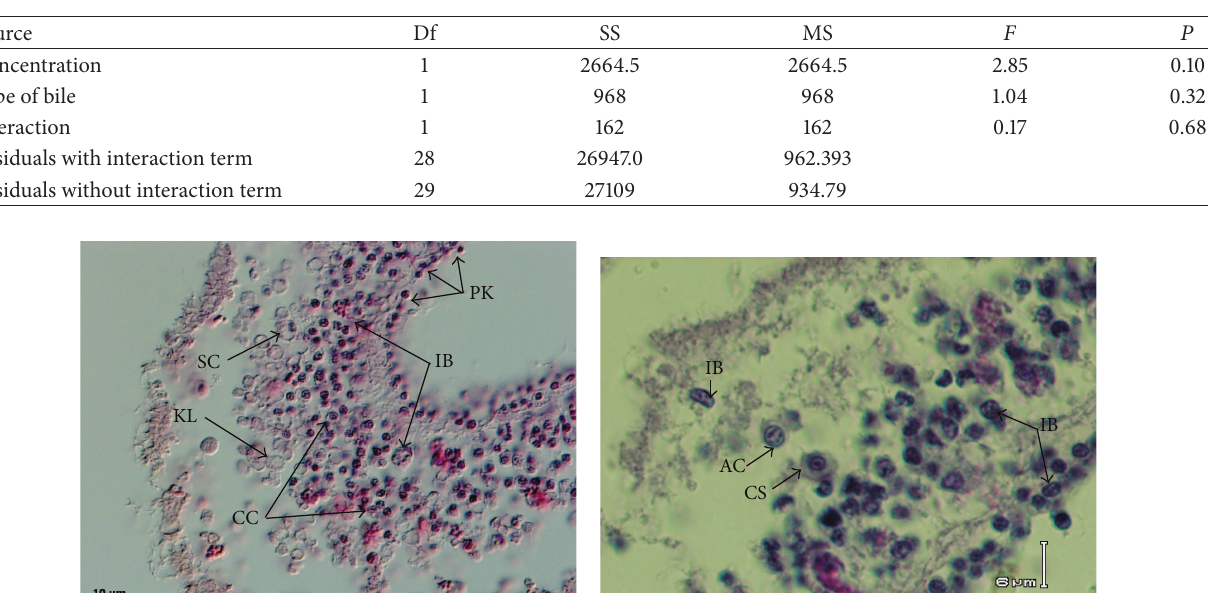
Table 1: Significance of the concentration and/or type of oxbile used on the time to death.